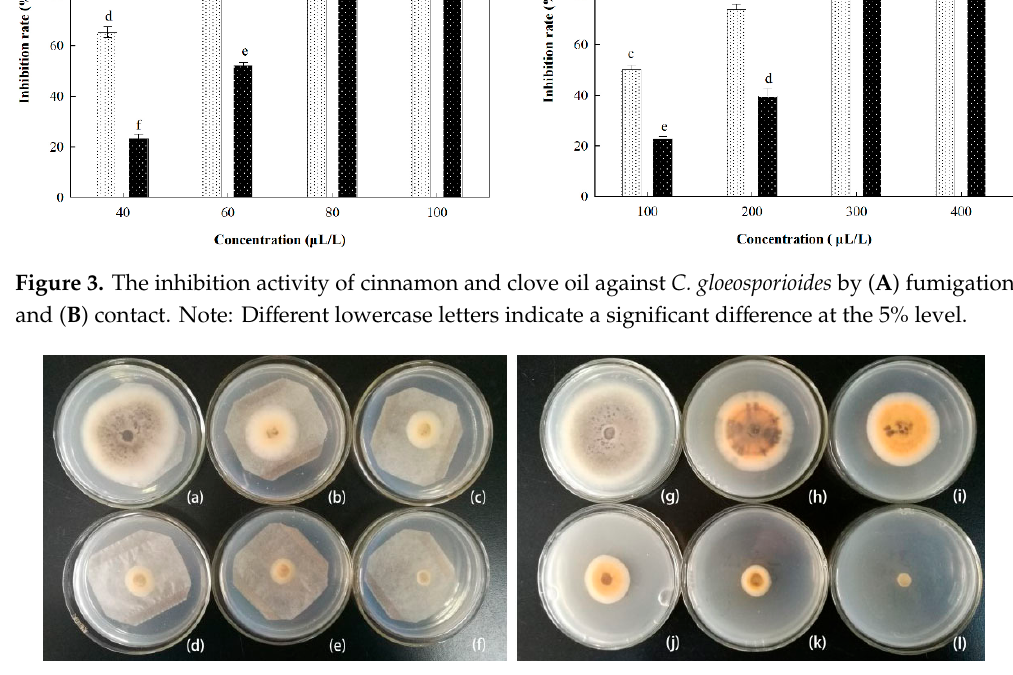
Figure 4. Radial growth of C. gloeosporioides mycelium treated with clove oil at 40 µ L / L ( b ), 60 µ L / L ( c ),